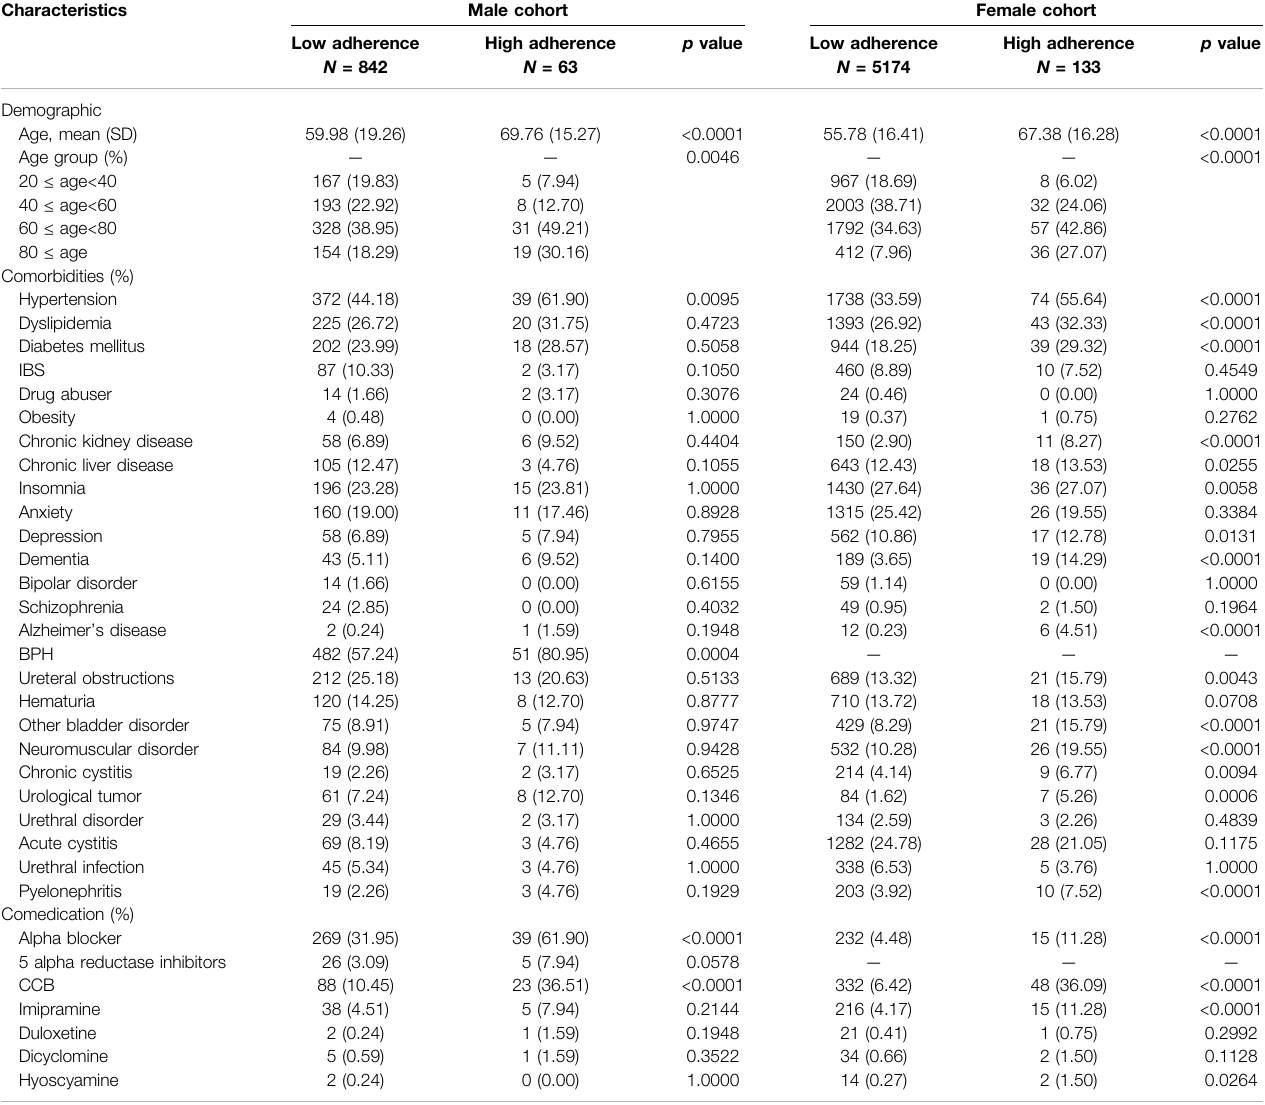
TABLE 1 | Baseline characteristics of the cohort, as strati fi ed by sex and adherence in the ever had UTI history group.